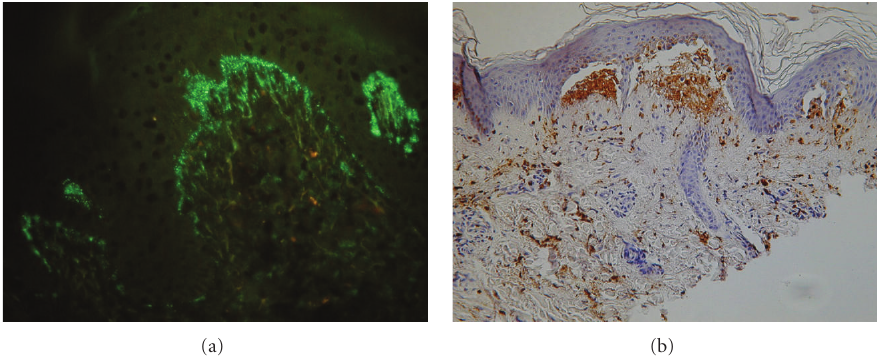
Figure 1: (a) Microgranular and fibrillar IgA1 deposits at dermal papillae in DIF in a young man with DH (original magnification × 400). (b) Neutrophil elastase deposits in immunohistochemistry in lesional skin in a middle-aged woman with DH (original magnification, ×